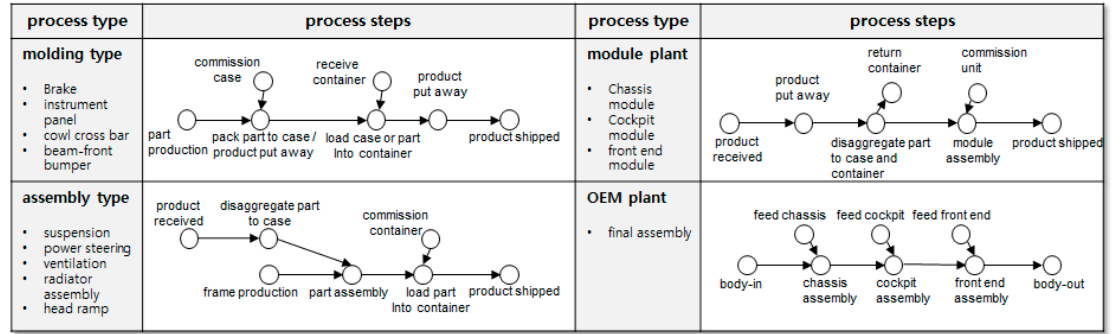
Figure 9. Overall supply chain.